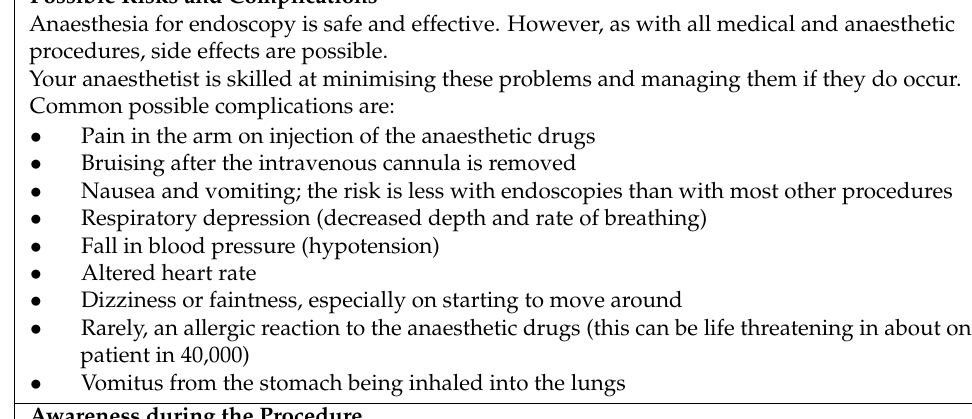
Table 2. ASA “Anaesthesia for Endoscopy” information sheet—section on possible adverse effects and potential awareness. Potential awareness during the procedure was highlighted by a head- ing and covered in more detail. Permission to publish obtained from Mi-tec Medical Publishing, Camberwell,